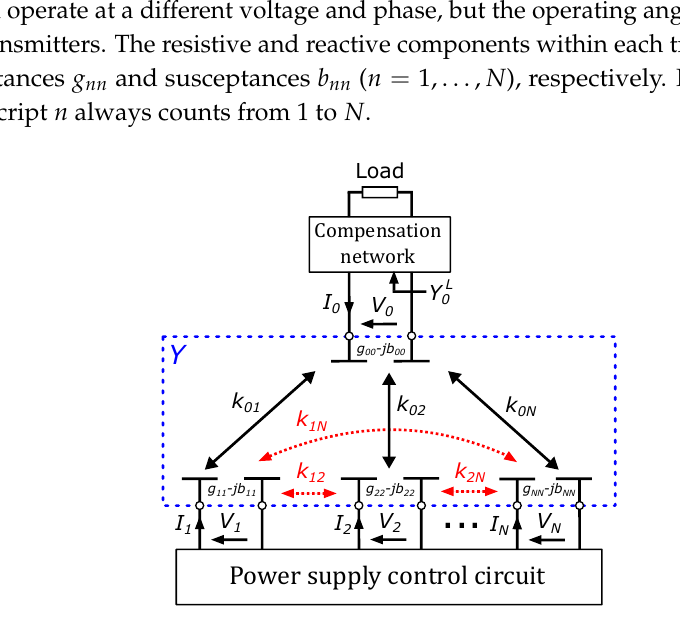
Figure 1. A general capacitive wireless power transfer system with N transmitters (bottom) and a single receiver (top). The (desired) electric couplings between transmitters and receiver are depicted by the full arrows. The undesired cross-couplings between the transmitters themselves are indicated by the dashed